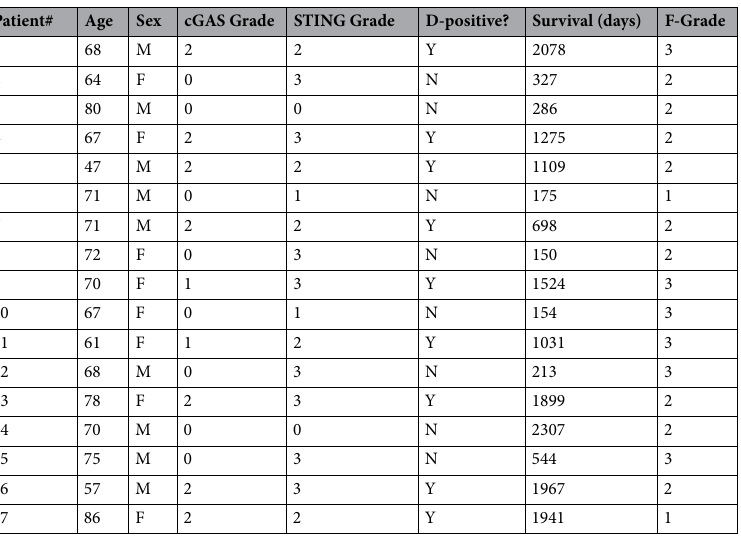
Table 1. Biological features of 17 FFPE samples. M, Male; F, Female; D-positive, cGAS and STING expression double-positive; F-Grade, fibrosis grade in the tissue.